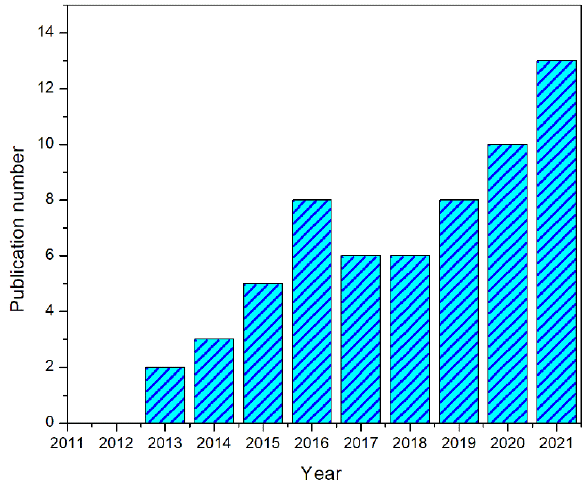
Figure 1. Distribution of scientific publications per year on sustainable materials derived from fish waste for electrochemical storage systems (Scopus database) .